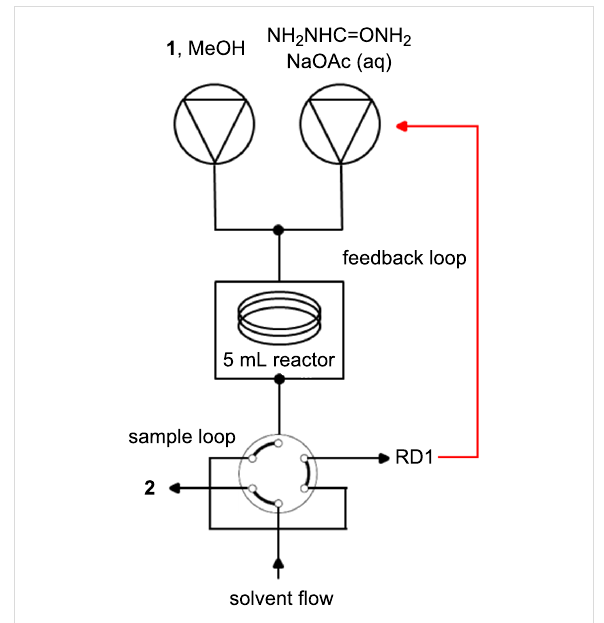
Figure 3: Reactor set-up for carvone optimisation using RD1 as an inline spectroscopic flow cell. Reagents were pumped using an Agilent 1100 series HPLC pumping module. A Uniqsis FlowSyn was used to heat and cool the 5 mL stainless steel coil reactor. The flow passed onto a stand-alone six-port valve, whereby samples were either passed into a collection vial or passed through RD1 which sat within the DAD compartment of the same Agilent 1100 series